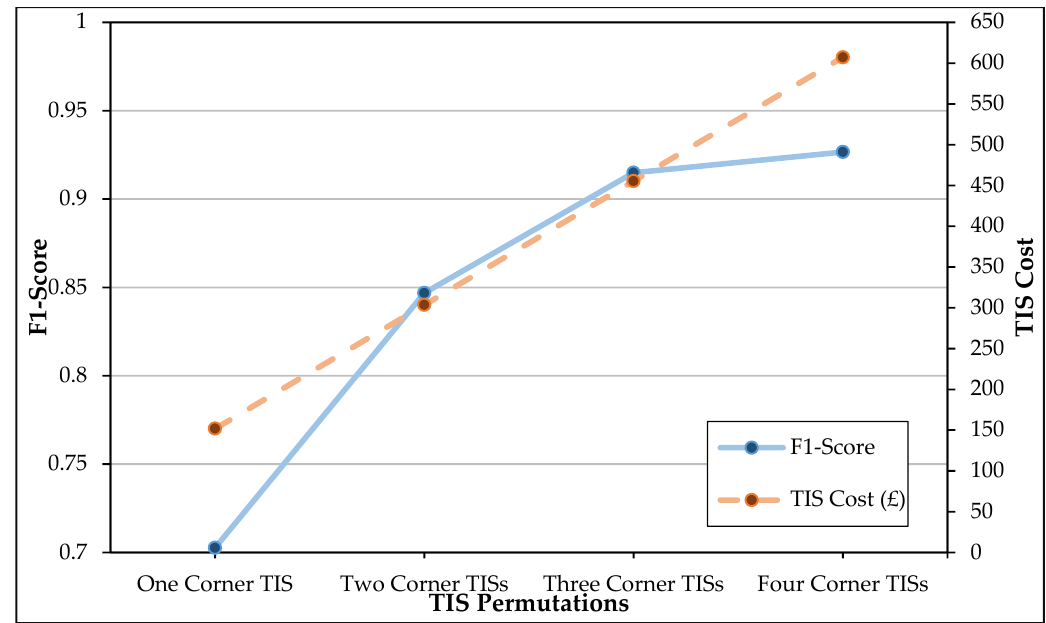
Figure 6. Trade-o ff between the number of TISs and CNNs, performance and cost of the TISs. Figure 6. Trade-off between the number of TISs and CNNs, performance and cost of the TISs.